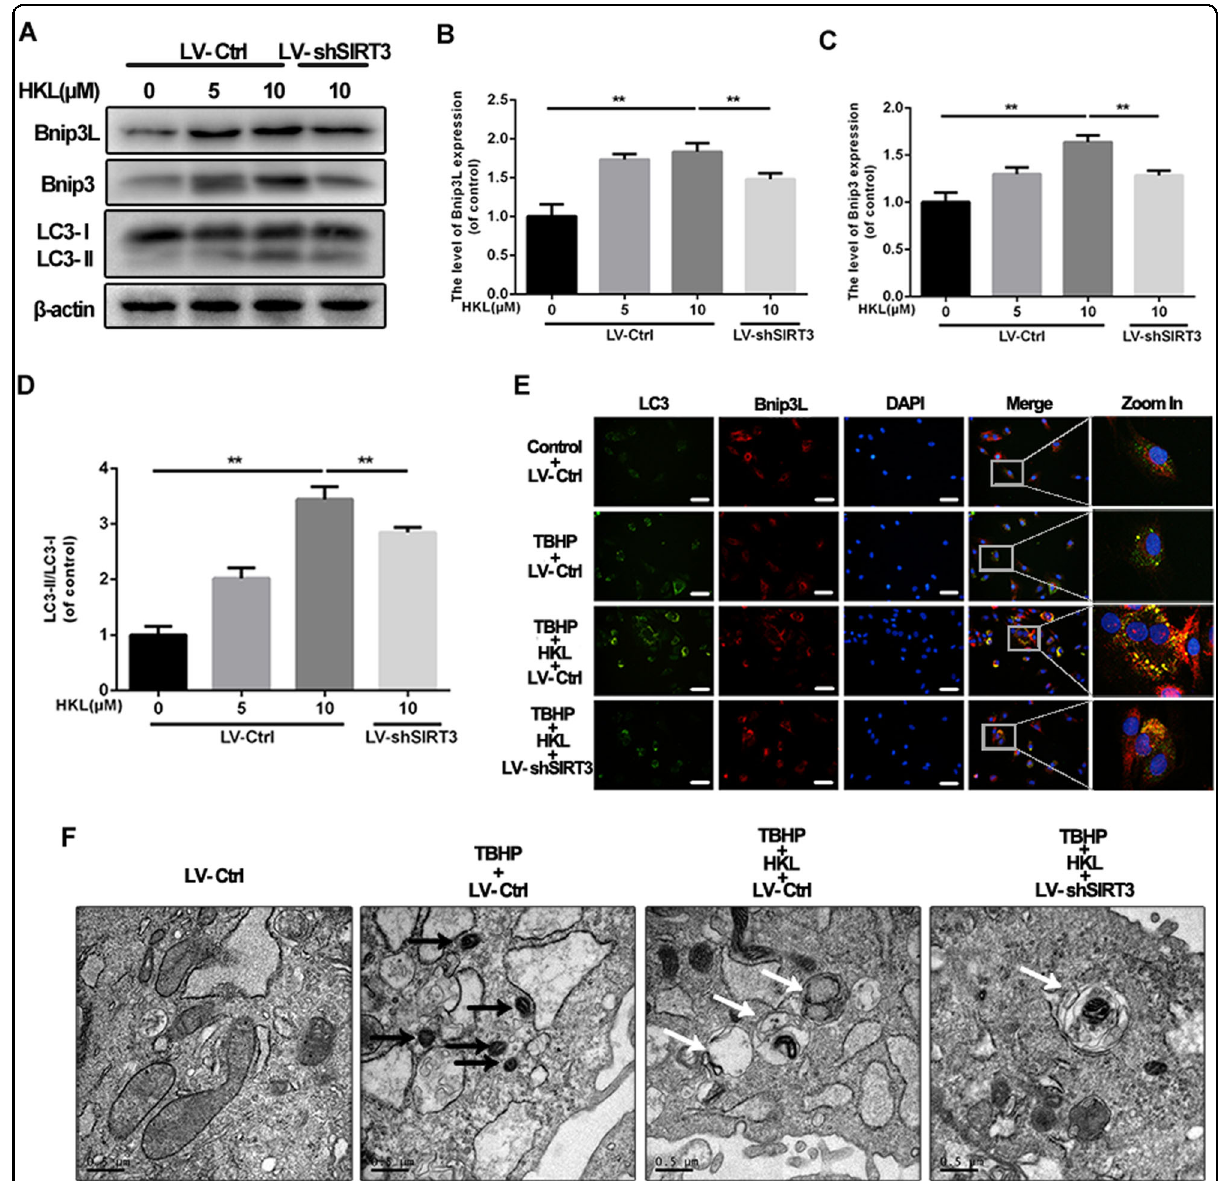
Fig. 5 HKL promotes mitophagy in an SIRT3-dependent manner in rat NPCs. a – d western blots of mitophagy markers, including Bnip3L, Bnip3, and LC3. HKL increased the mitophagy markers Nix and Bnip3 and the ratio of LC3-II/LC3-I by activating SIRT3. e The representative colocalization of LC3 and Bnip3L is detected by immuno fl uorescence staining. Scale bar: 50 μ M. f Transmission electron microscopy was used to detect the mitophagosomes (×25,000) in nucleus pulposus cells. (Black arrow: mitochondria; white arrow: mitophagy). All experiments were performed in duplicate, and data are reported as the mean ± SD. * P < 0.05, ** P <